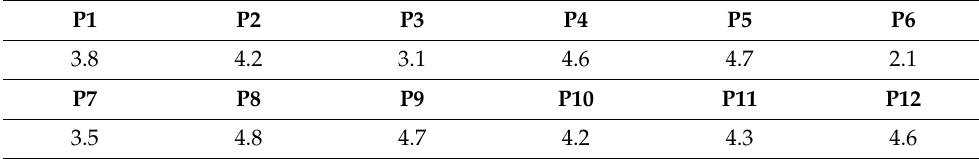
Table 2. Results of the immersion measurement questionnaire.